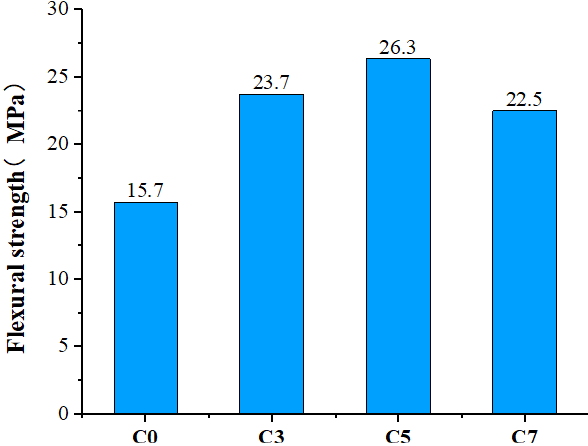
Figure 7: (a) Dispersion of MWCNTs in UHPC; (b) Dispersion of MWC- NTs in ordinary